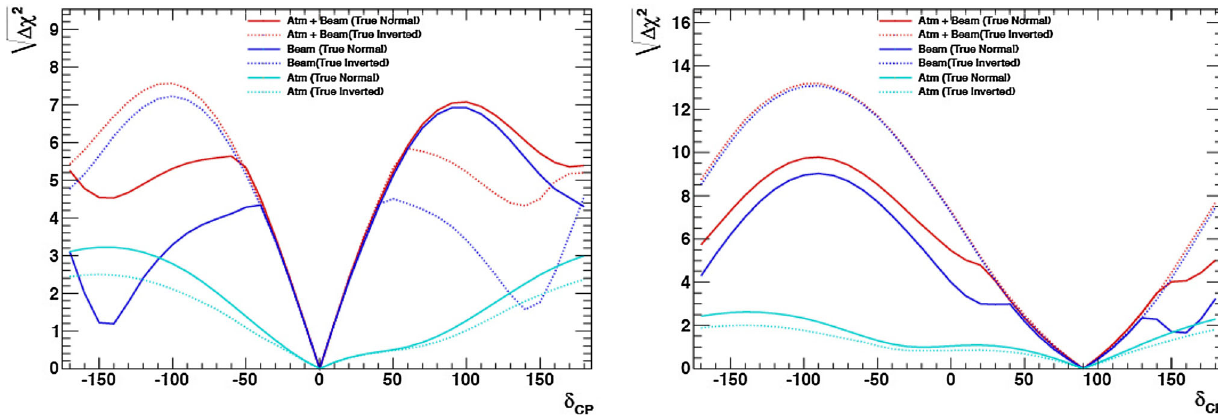
Fig. 16 The sensitivity for the CP phase assuming 0 ◦ (left) and 90 ◦ (right) [66]. The lines show the results from various combinations of the experiments. The atmospheric neutrino study alone in HK is not sufficient to conclude and combination with the beam neutrino study is